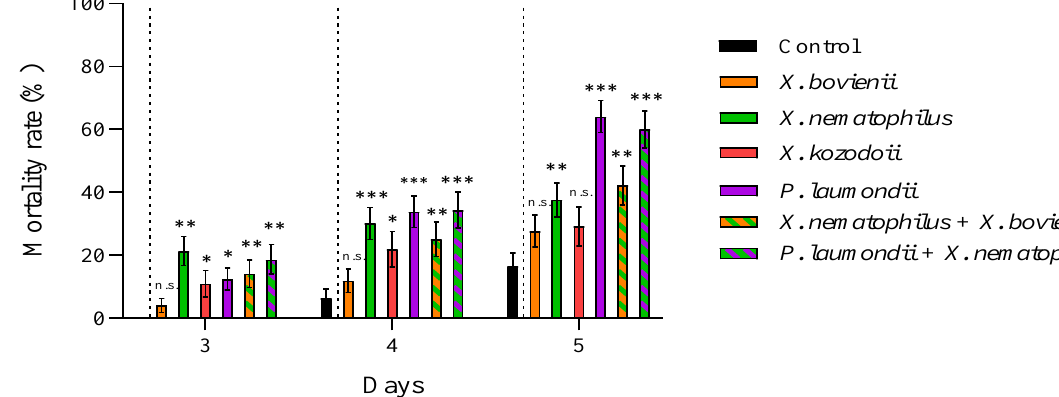
Figure 2. Entomopathogenic nematode (EPN) pathogenicity against Philaenus spumarius nymphs. Cumulative larval mortality (three to five days) for the EPN species Steinernema feltiae , S. carpocapsae , S. riojaense, Heterorhabditis bacteriophora , and the absence of nematodes (control). Asterisks indicate significant differences at *** p < 0.001, * p < 0.05, and n.s., not significant, for generalized linear models testing within pair-treatment comparisons of inoculations and no inoculations (control) of EPNs. Values are least-square means ± SE.